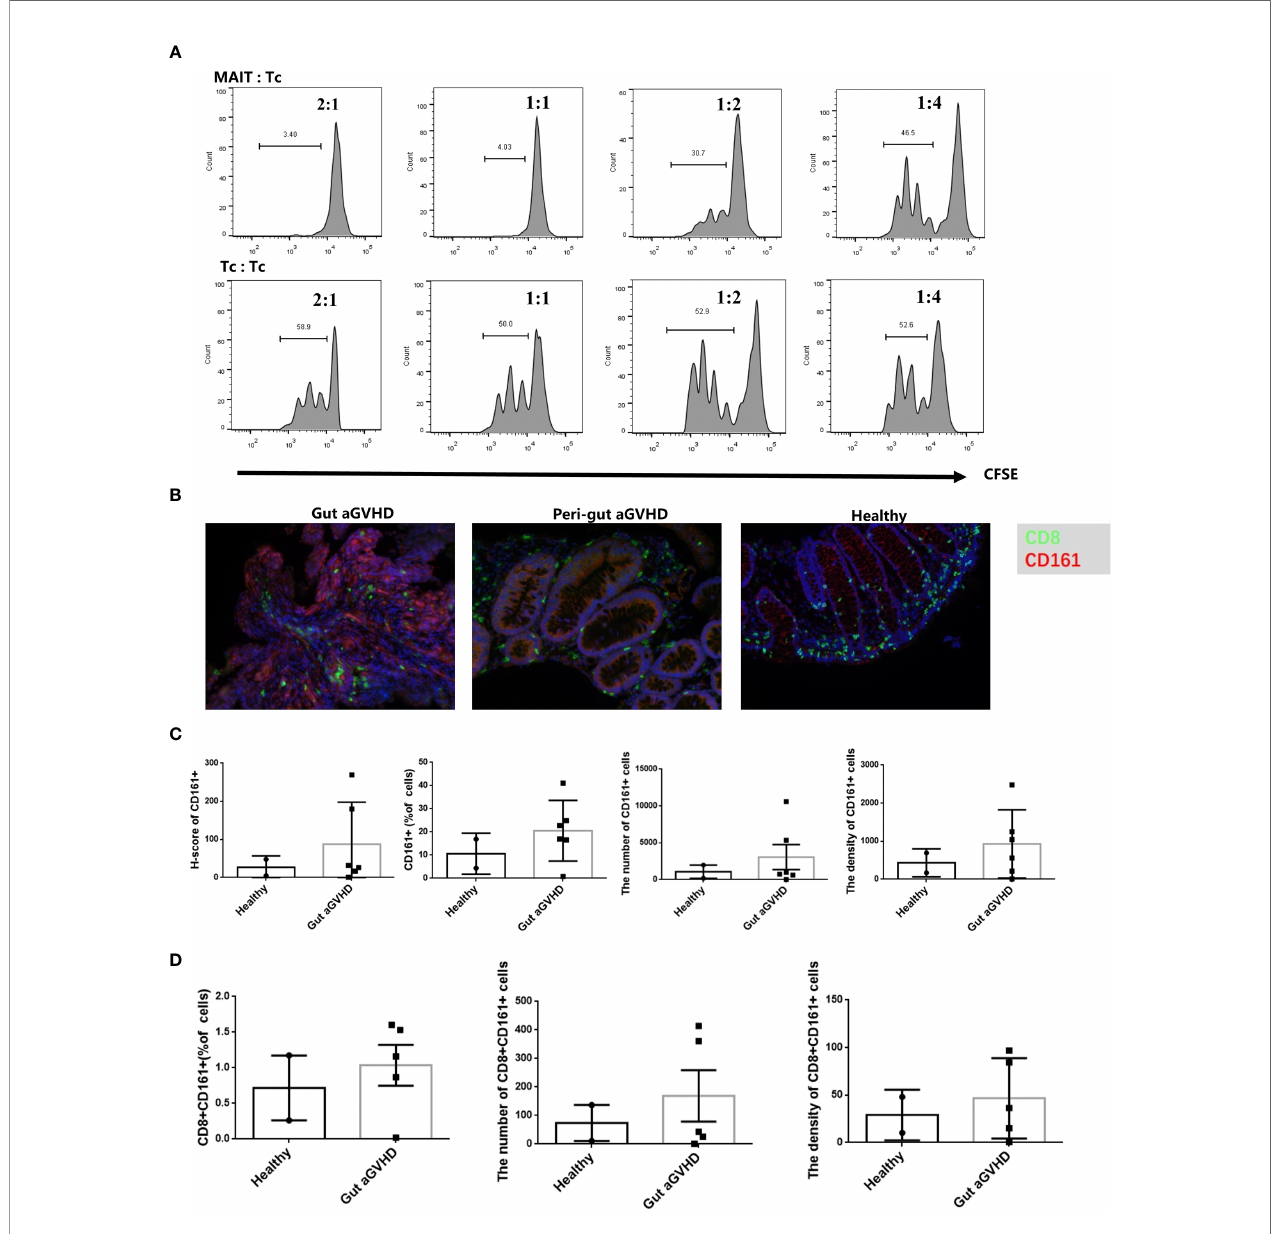
FIGURE 7 | The in vitro inhibition experiment of mucosa-associated invariant T (MAIT) cells on CD4+ T cells and immuno fl uorescence experiment of intestinal tissue. (A) MAIT cells and CD4+ T cells were isolated from the peripheral blood of four healthy donors. Here, 5,6-carboxy- fl uorescein diacetate succinimidyl ester (CFSE)-labeled CD4+ T cells with CD3/CD28 bead stimulation and MAIT cells or CD4+ T cells were mixed and cultured at a ratio of 2:1, 1:2, 1:4, and 1:8 for 4 days. Representative fl ow cytometric analysis of CFSE dilutions in CD4+ T cells. (B) Immuno fl uorescence of intestinal tissues of healthy people, gut aGVHD lesion sites and peri-gut aGVHD sites of gut aGVHD patients. (C) Comparison of CD161 staining intensity, CD161-positive cell ratio, number, and density between healthy person intestinal tissue (n = 2) and intestinal lesion tissue of gut aGVHD patients (n = 5). Since only one case of gut aGVHD patient in the experiment received the intestinal tissue of peri-gut aGVHD site, there is no peri-gut aGVHD group in the comparison. (D) Comparison of CD8+CD161+ cell ratio, number, and density between healthy person intestinal tissue (n = 2) and intestinal lesion tissue of gut aGVHD patients (n =